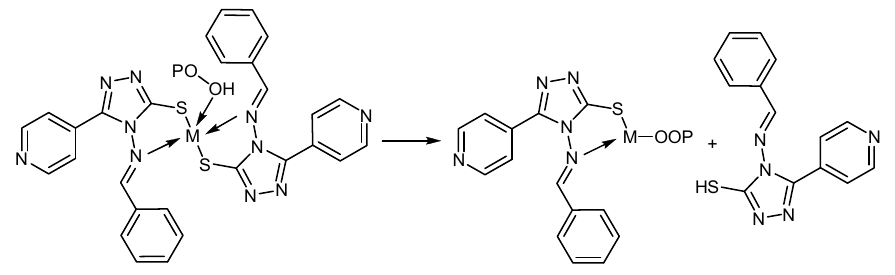
Scheme 2. Additives act as UV Absorbers.